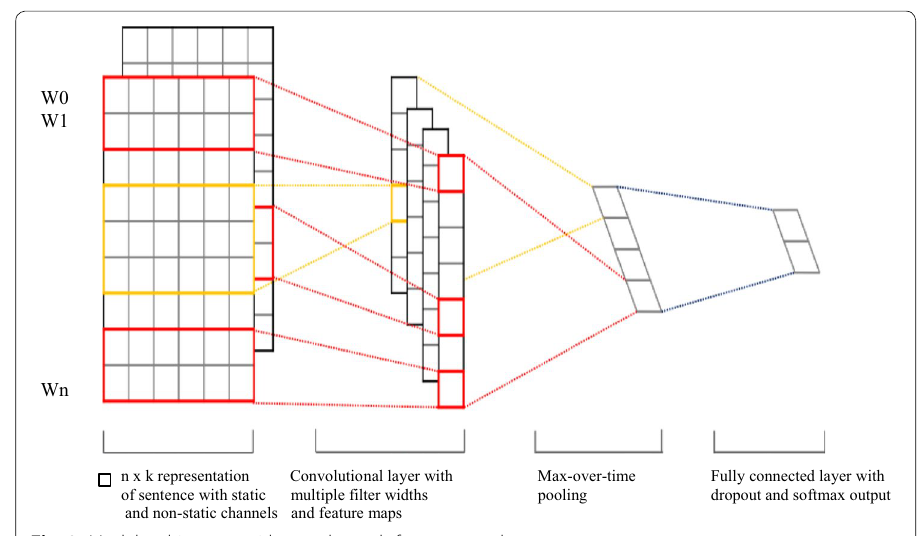
Fig. 2 Model architecture with two channels for an example